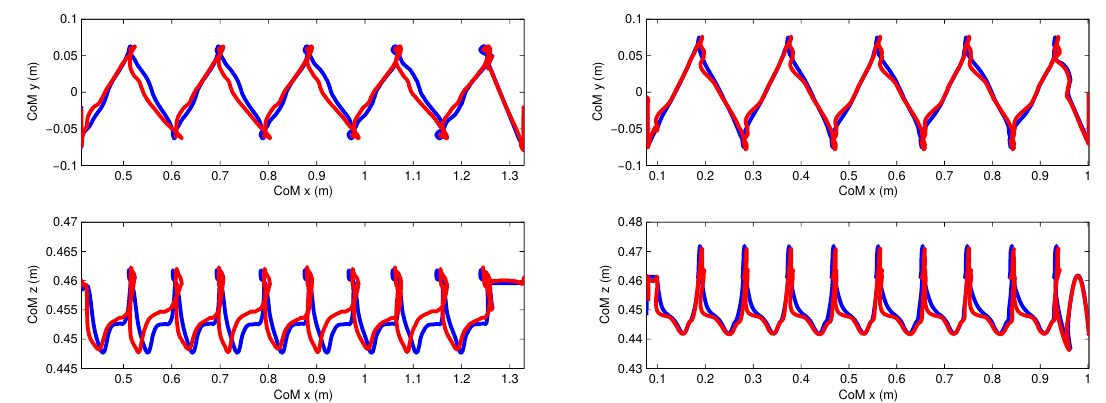
Figure 10. [Hardware experiment result.] Center of mass trajectories obtained on the robot (in red) with all four combinations of objective functions as in Table